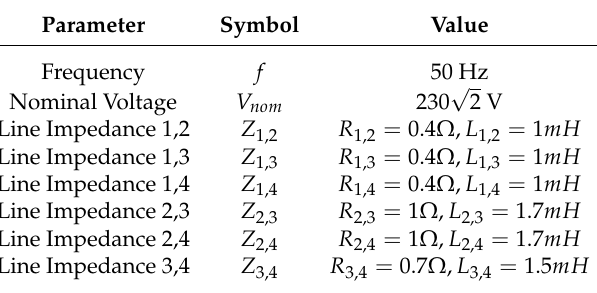
Table 1. Electrical system